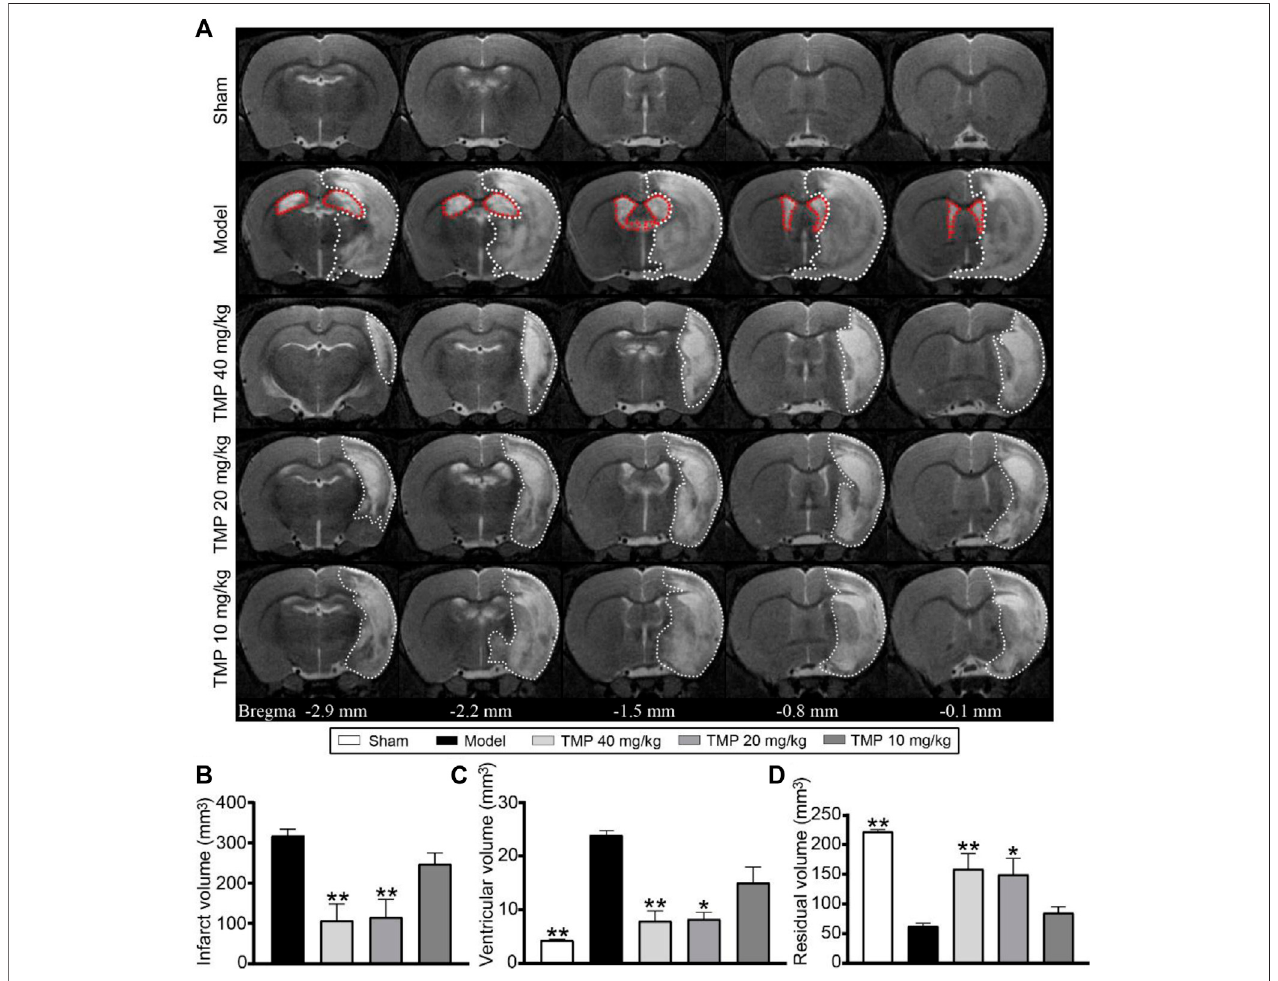
FIGURE 1 | Effect of TMP on cerebral infarction in MCAO rats. (A) Typical axial T2 imagesof each group. The infarct areas are represented with white dotted lines. The ventricles are represented with red dotted lines in the model group ( n = 6). Quantitative analysis of the (B) infarct volume, (C) ventricular volume, and (D) residual volume. * p < 0.05 and ** p < 0.01 vs. Model